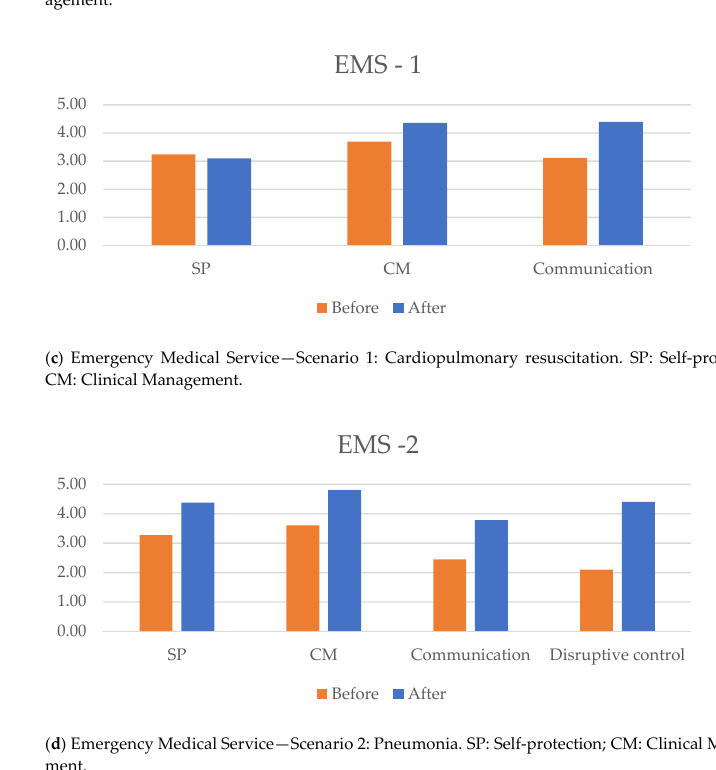
Figure 2. Overall score for each dimension for the different scenarios in the initial and repeat eval- uations.